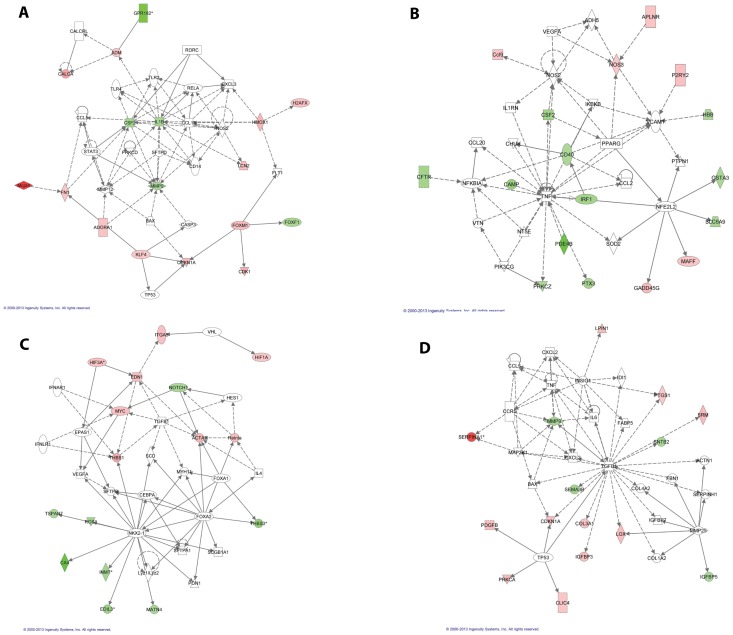
Networks involving deregulated genes in Foxf1+/− lungs identified using IPA.Deregulated genes involved in (A) Inflammatory response, cellular movement, cardiovascular disease; (B) Cell-to-cell signaling and interaction, cellular movement, hematological system development and function; (C) Embryonic development, organ development; (D) Cardiovascular system development and function, organ development, cellular movement; down-regulated genes are shown in green and up-regulated gens are shown in red.